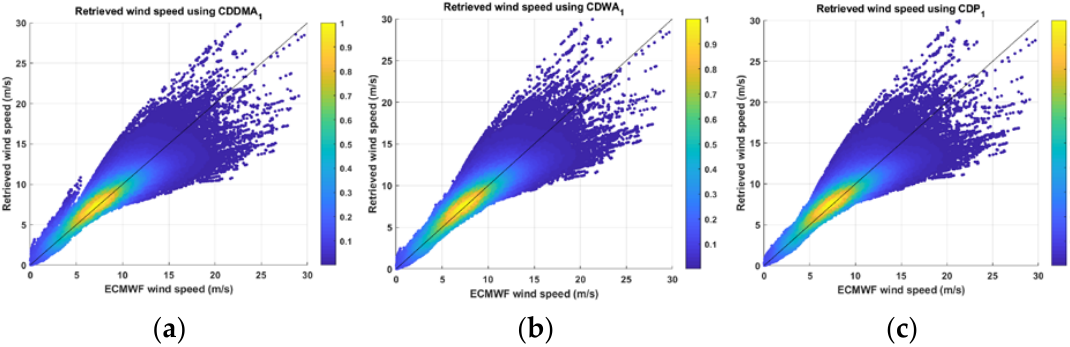
Figure 11. Overall research flow diagram, including the simulation of the TRITON ground track and corresponding reflection events, the proposed GNSS-R measurements and the observables, and the ground truth data generated for the performance evaluation.